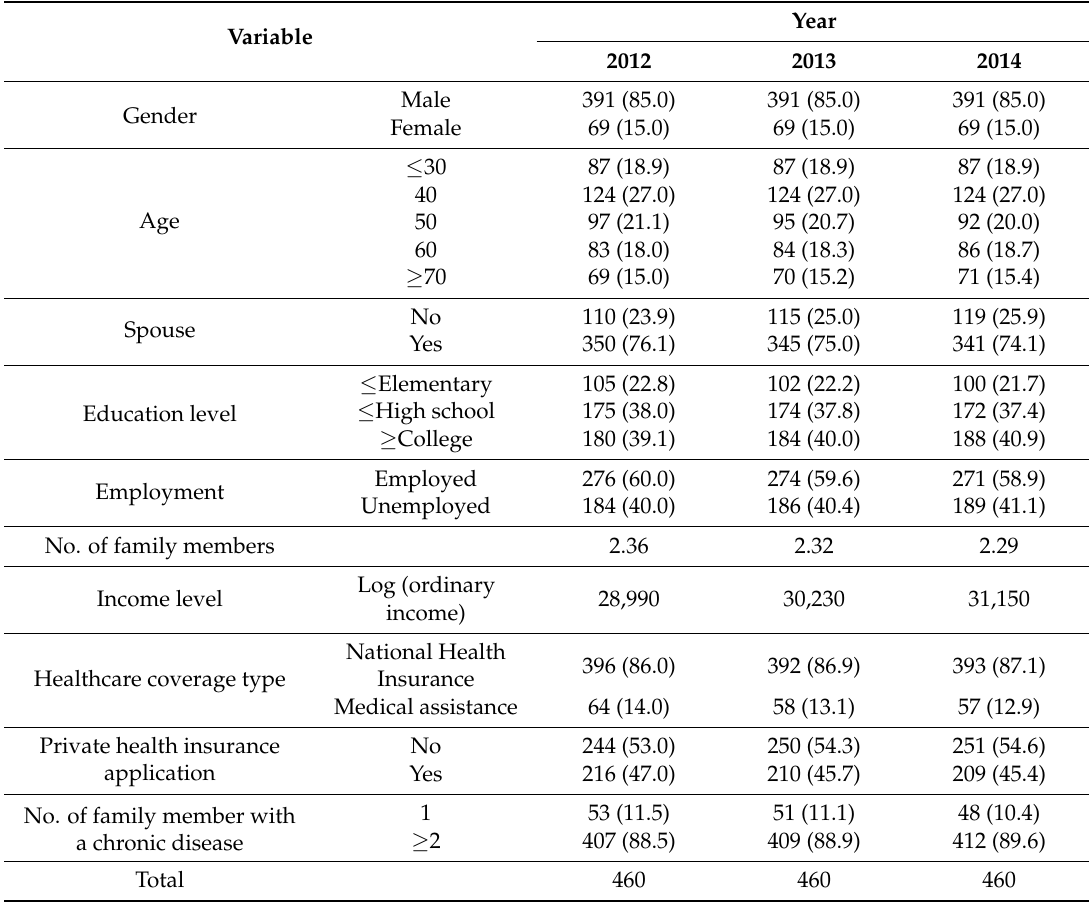
Table 2. General characteristics of households with cancer